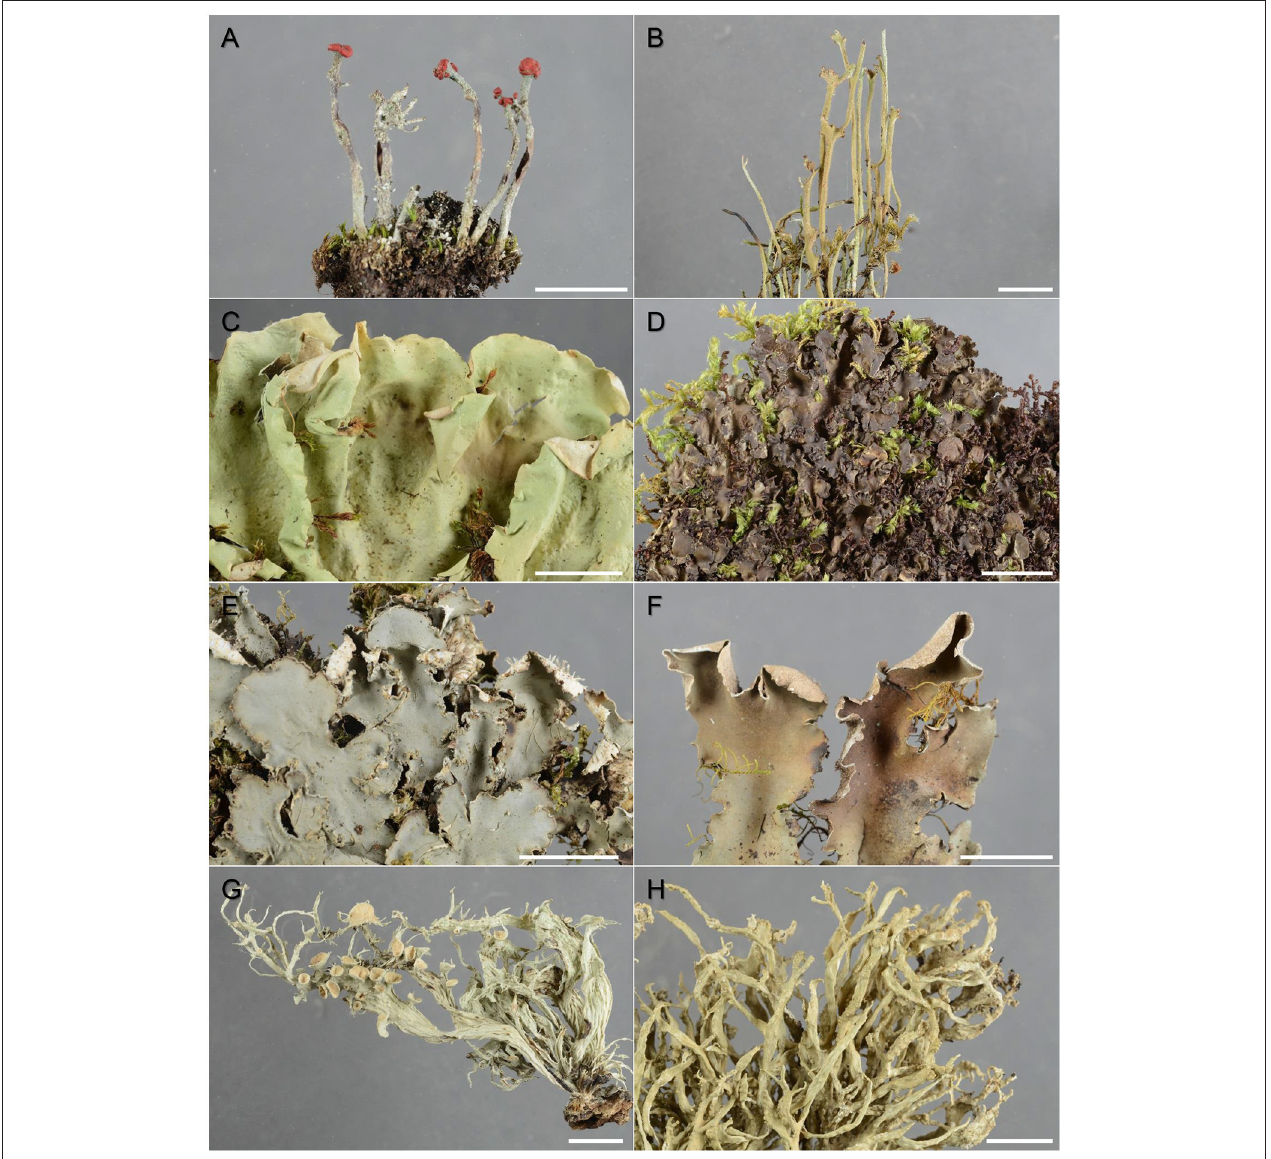
FIGURE 1 | Lichen species targeted in this study (specimens from the 2010-period): (A) Cladonia floerkeana , (B) C. gracilis , (C) Nephroma acrticum , (D) N. laevigatum , (E) Peltigera collina , (F) P. malacea , (G) Ramalina fraxinea , and (H) R. siliquosa . Scale bar = 1cm.